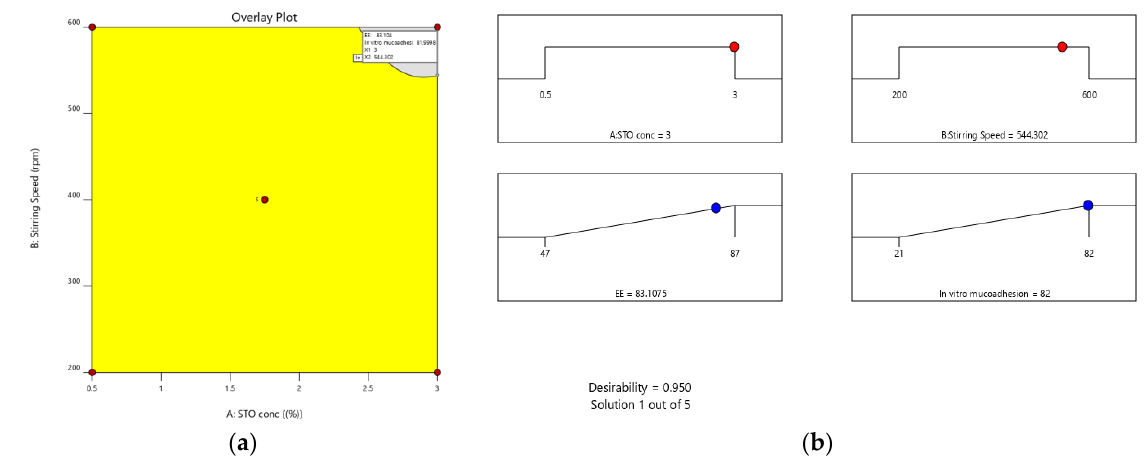
Figure 4. ( a ) Overlay plot and ( b ) desirability bar graph for an optimized result.